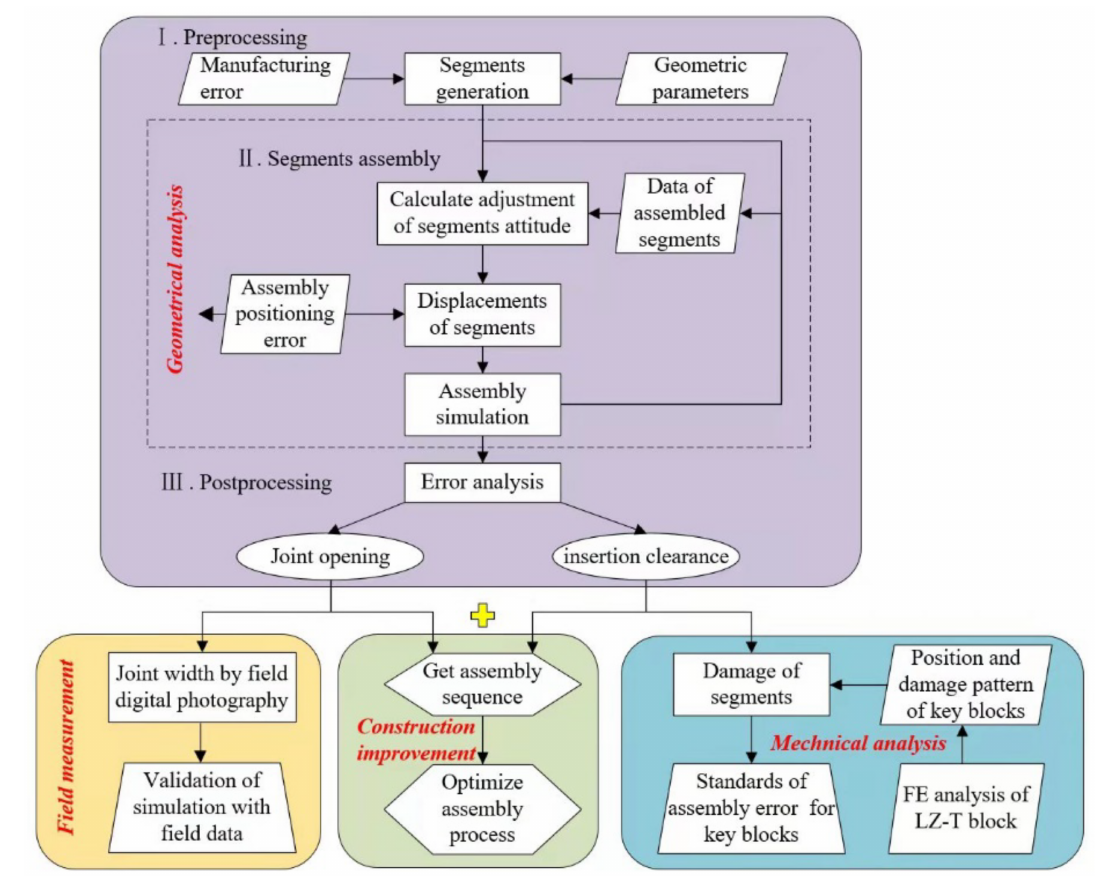
Figure 3. Overall technical route